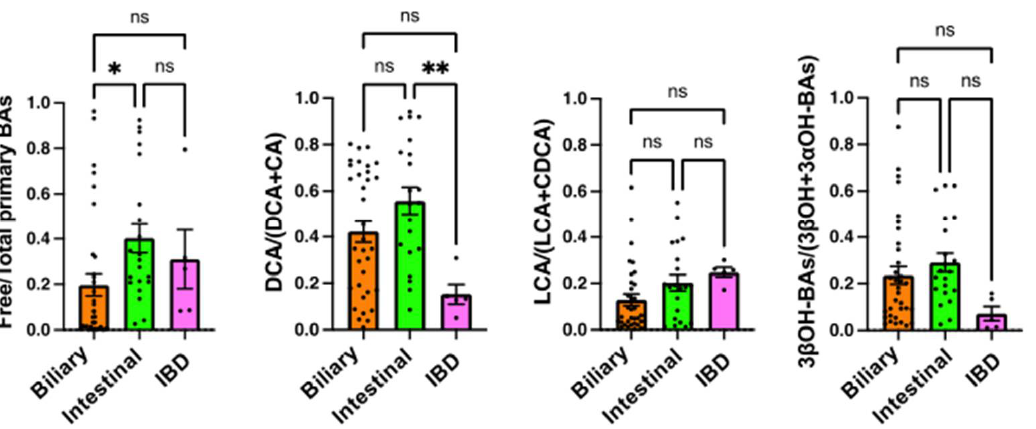
Figure 3. Comparison of serum BA markers among patients with different underlying diseases. Se- rum samples were obtained on admission (prior to antibiotic use and CDI onset). Biliary, patients with hepato-biliary-pancreatic diseases ( n = 34); Intestinal, patients with gastrointestinal diseases ( n = 21); IBD, patients with inflammatory bowel diseases ( n = 5). Each column and error bar represents the mean and SEM. According to the Tukey–Kramer test, * p < 0.05 and ** p < 0.01 were significantly different; ns, not significant.